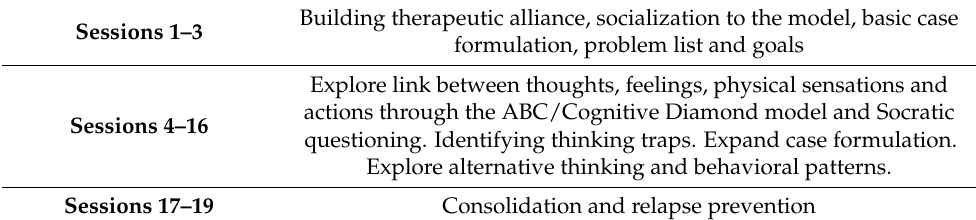
Table 2. Description of the treatment